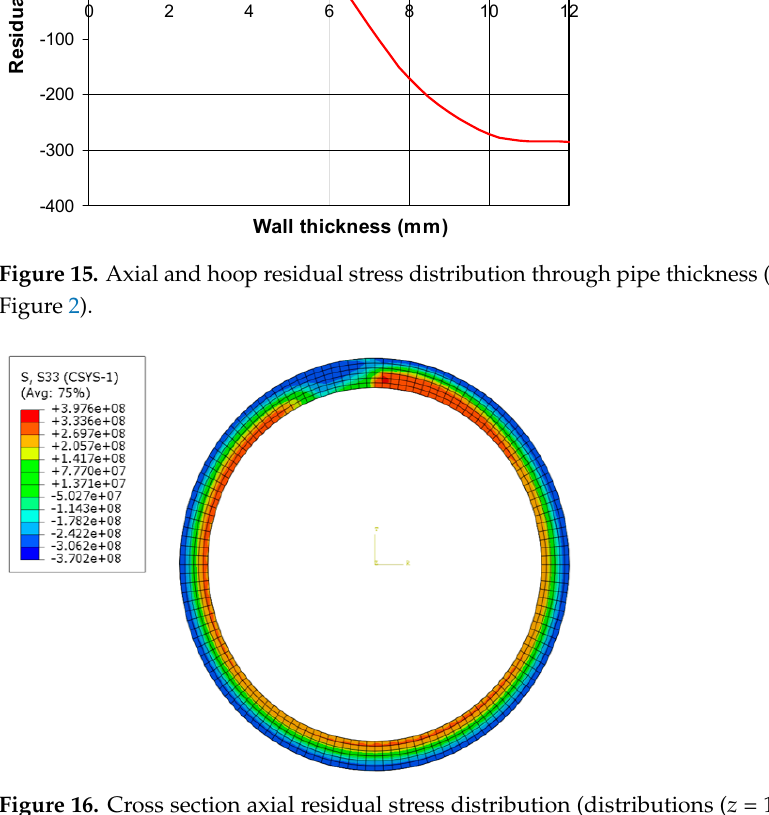
Figure 16. Cross section axial residual stress distribution (distributions ( z = 156 mm, Section A-A, Figure 2).